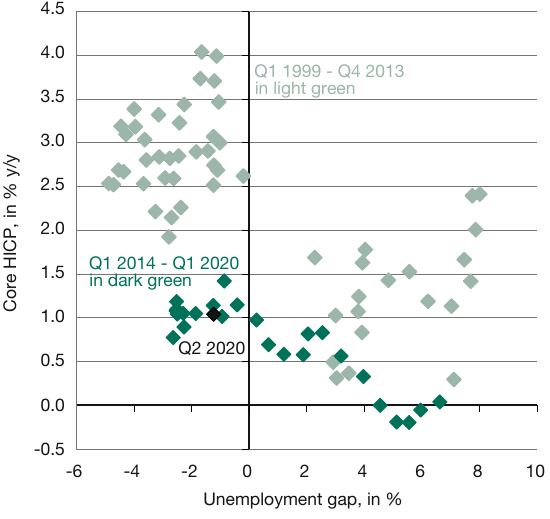
Source: Haver Analytics.